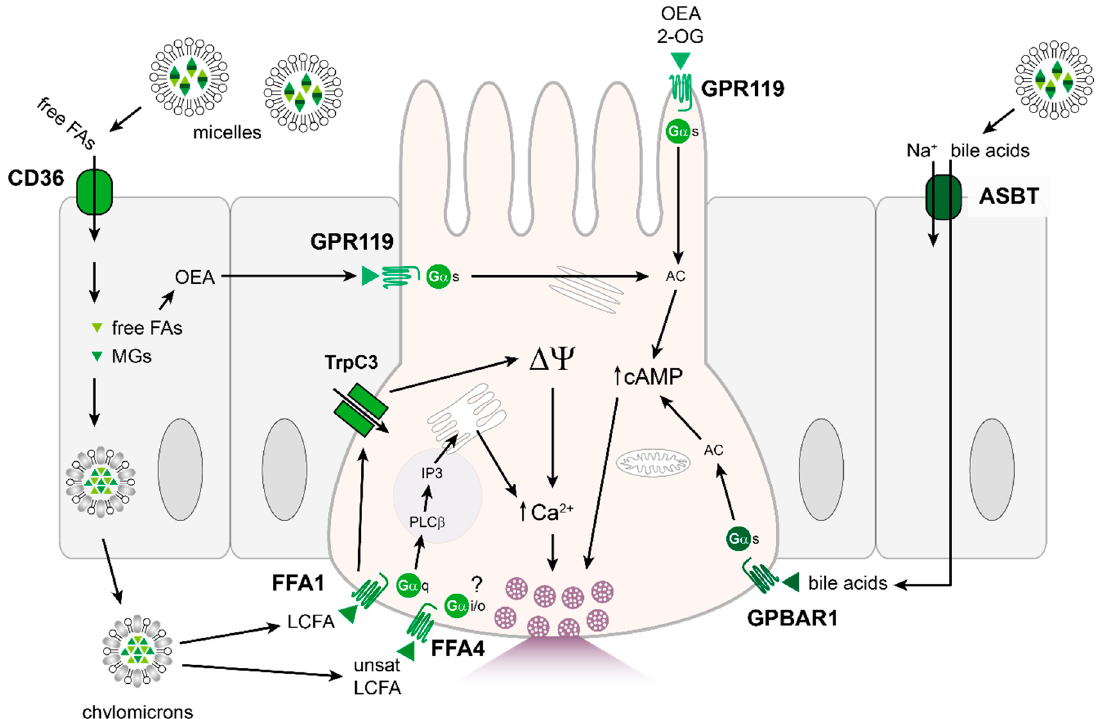
Figure 4. Fat-sensing mechanisms in incretin hormone secreting EECs. Lipid sensing appears dominated by activation of G-protein coupled receptors. Contrary to what had been thought originally, these do not directly sample the luminal contents, but are shielded behind lipid absorption by enterocytes, with the possible exception of the mono-acyl-glyceride sensor GPR119. Absorption of micelles and formation of chylomicrons through enterocytes is illustrated on the left. Bile acids, which assist in the emulsification and breakdown of fatty acids, also stimulate incretin hormone secretion and the mechanism of bile acid-sensing in EECs is illustrated in dark green on right side of EEC. Transport route for conjugated bile acids in the small intestine via ASBT, illustrated in enterocyte on the right. See text for details. Abbreviations: 2-OG, 2-oleoylglycerol; AC, adenylyl cyclase; ASBT, sodium-dependent bile acid transporter; cAMP, cyclic adenosine monophosphate; CD36, cluster of differentiation also known as fatty acid translocase; FA; fatty acid; FFA1, free fatty acid receptor 1; FFA4, free fatty acid receptor 4; GPBAR1, G-protein coupled bile acid receptor 1; GPR119, G-protein coupled receptor 119; IP3, inositol triphosphate; LCFA, long-chain fatty acid; MG; monoglycerides; OEA, oleoylethanolamide; PLC β , phospholipase C beta; TrpC3, transient receptor potential cation channel subfamily C member 3; ΔΨ , membrane depolarization.